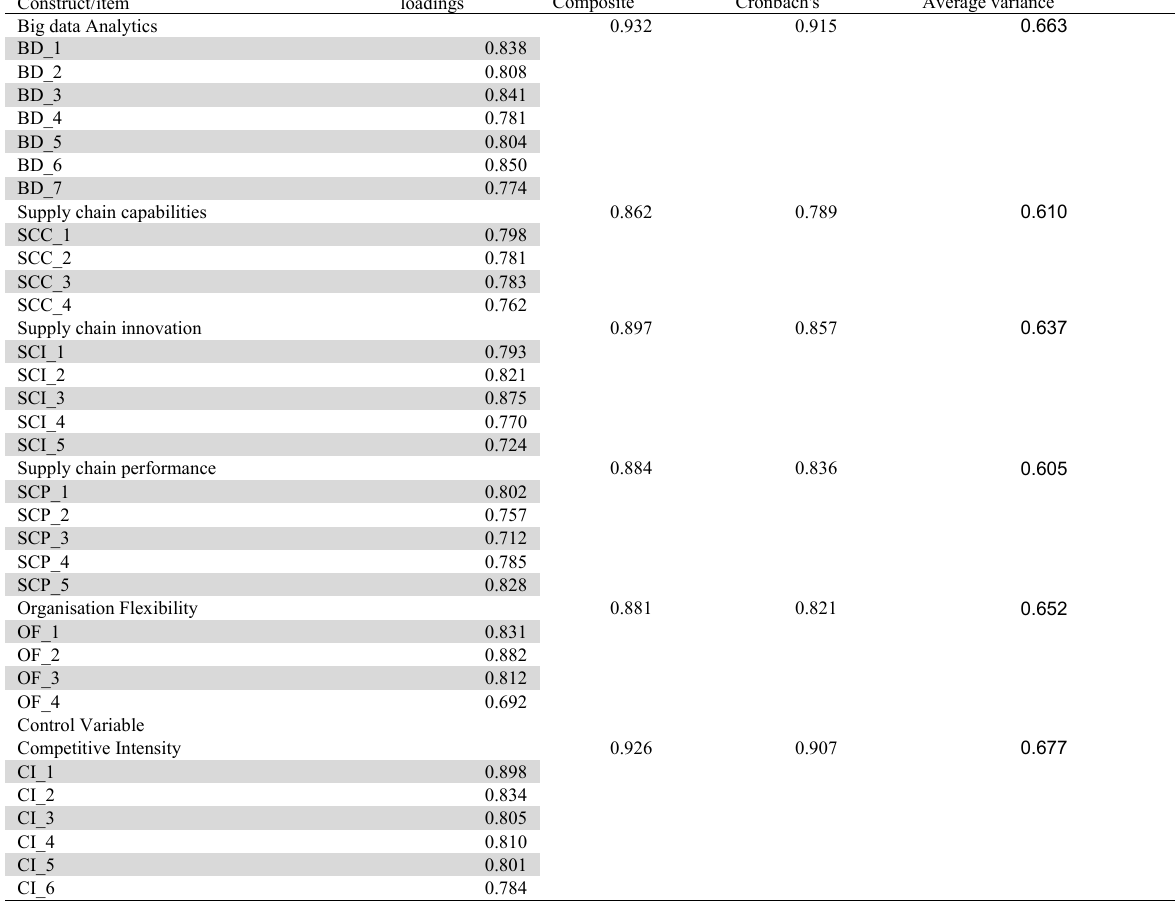
Estimation of the measurement model parameter